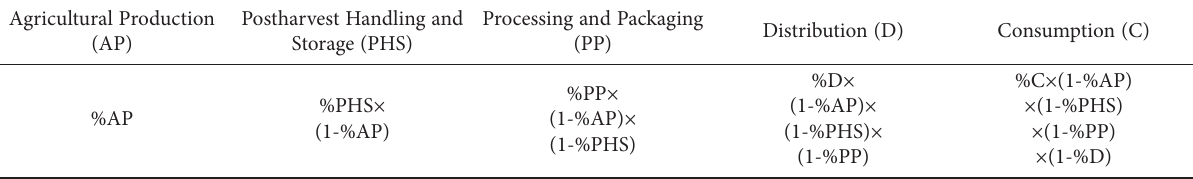
Table 1. Estimation guide for the percentage loss/waste accumulation in the FSC. Agricultural